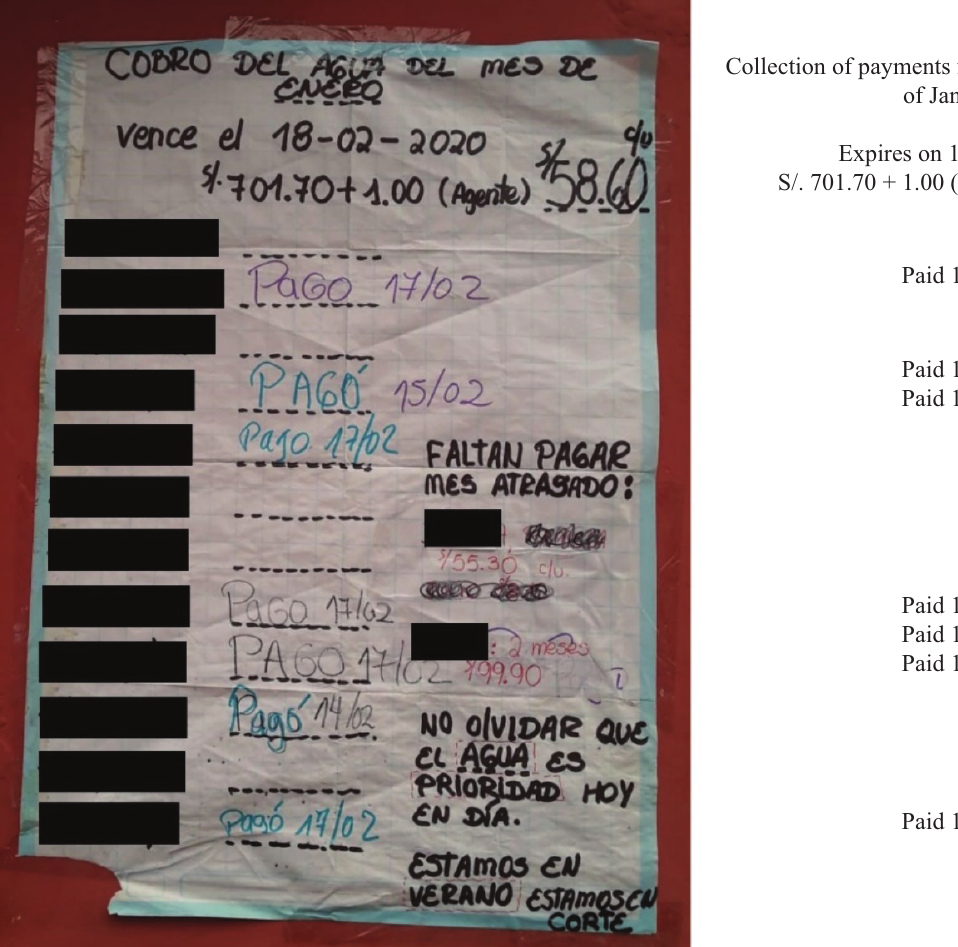
Figure 2. Poster on the communal wall in quinta, keeping track of the payments for the water bills. At the time, 58.60 soles corresponded to €16 or $17.3. Source: Liliana Miranda Sara. Translation by the